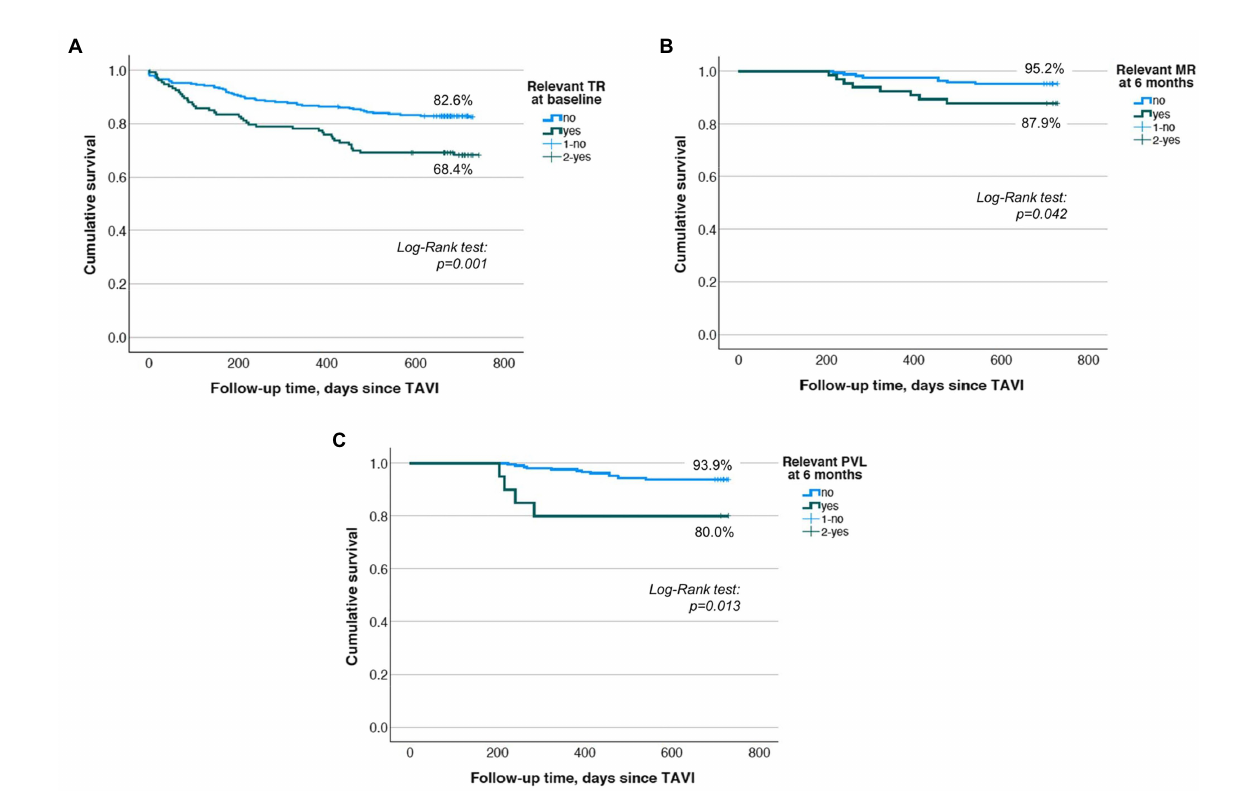
FIGURE 3 ( A ) Kaplan–Meier survival analysis for relevant TR at baseline displaying a significant survival benefit after 2 years for the group not showing relevant TR at baseline. ( B ) Kaplan–Meier survival analysis for relevant MR at the 6-month follow-up displaying a significant survival benefit after 2 years for the group not showing relevant MR 6 months after TAVI. ( C ) Kaplan–Meier survival analysis for relevant PVL at the 6-month follow-up displaying a significant survival benefit after 2 years for the group not showing relevant PVL 6 months after TAVI.